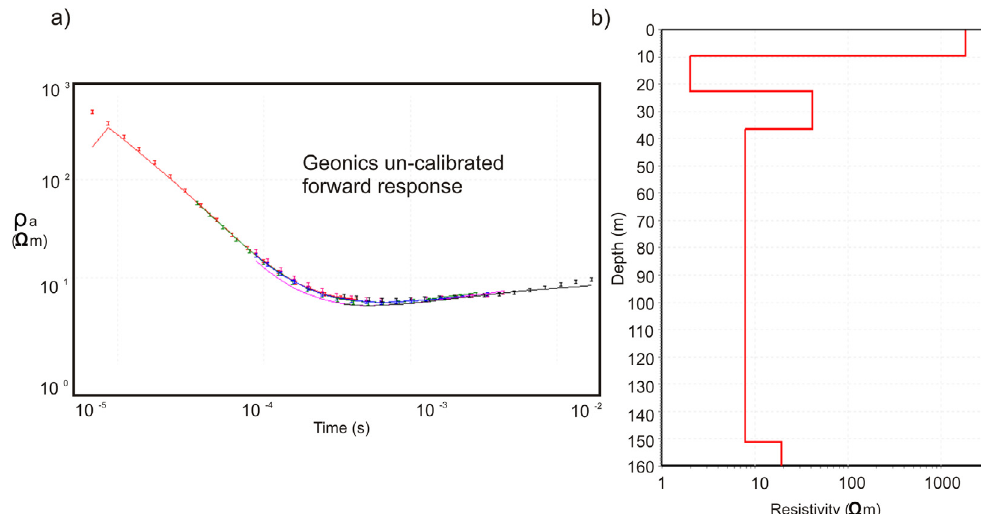
Figure 11. Un-calibrated 100 × 100 loop response obtained without amplitude and time shift factors correction. (a) Forward response (solid line) can not fit the observed data (error bars). (b) Recovered 1-D resistivity